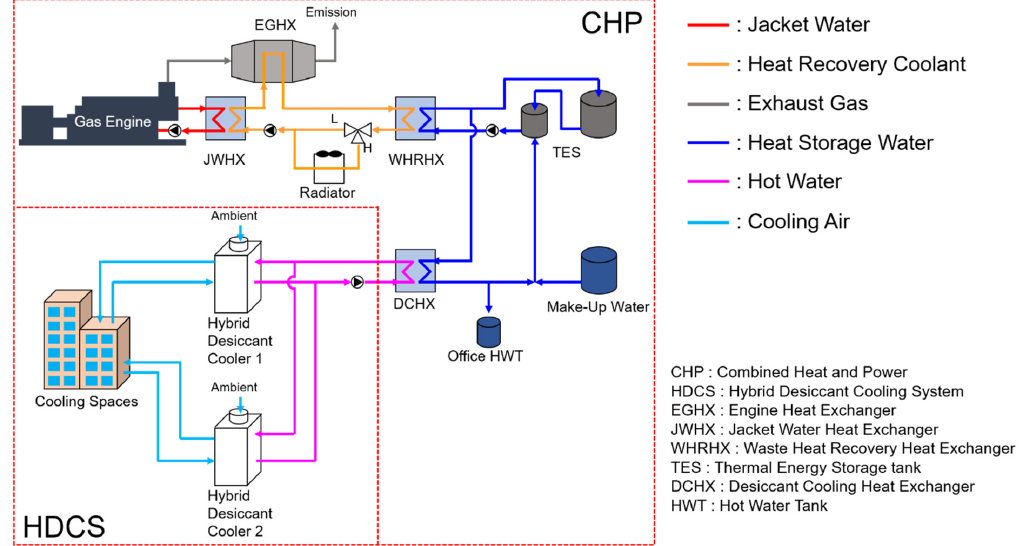
Figure 1. Schematic of the combined cooling, heat, and power (CCHP) system with a hybrid desiccant cooling system (HDCS).